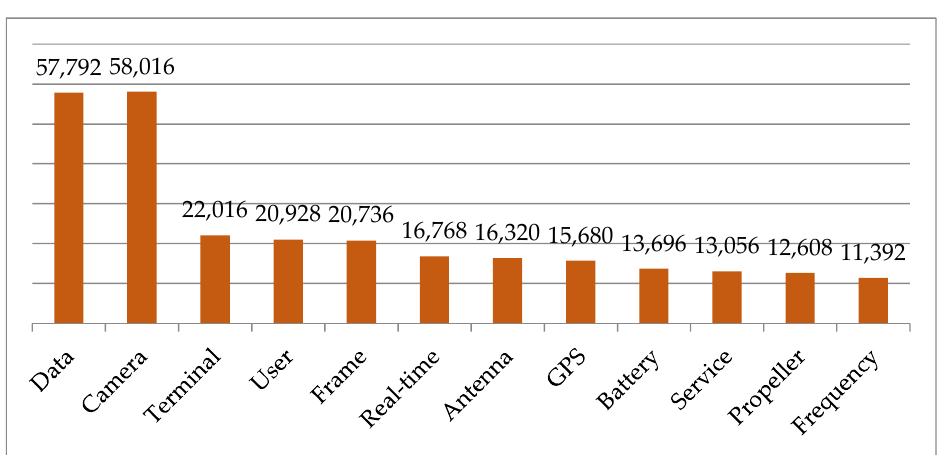
Figure 3. Top 12 words frequency.